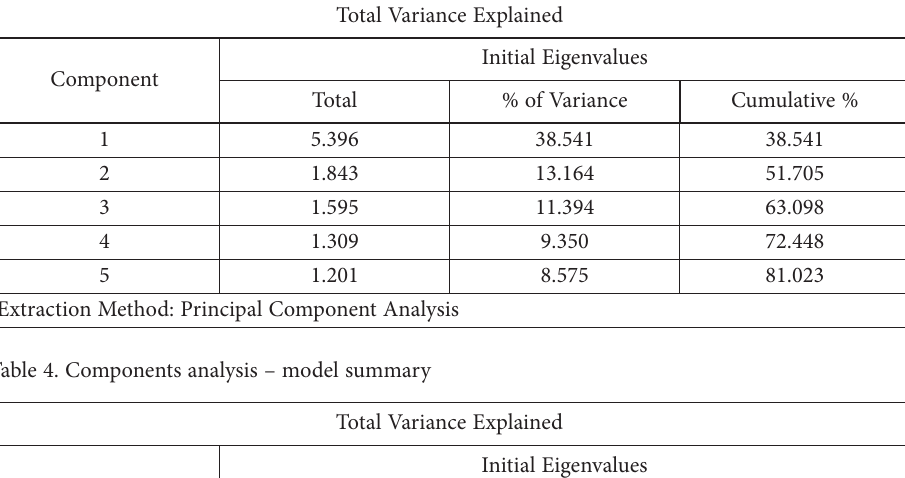
Total Variance Explained